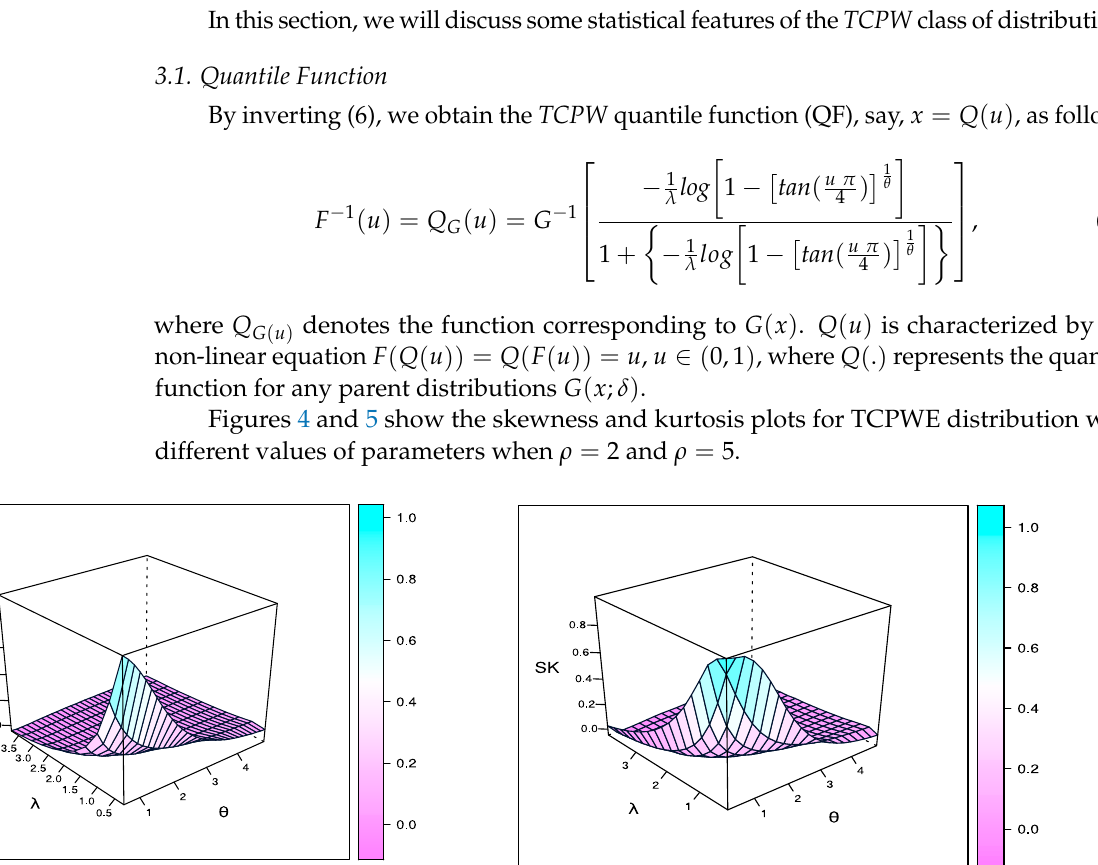
Figure 3. Plots of PDF and the hazard function of TCPWR distribution.